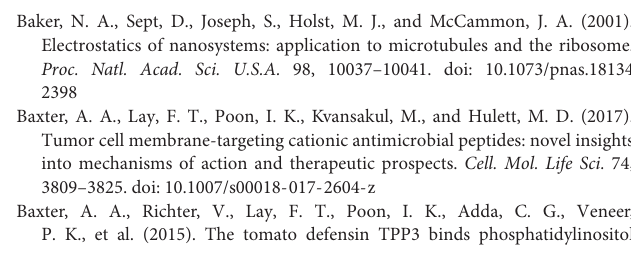
FIGURE S1 | Surface charge of ZmD32 like defensins. The structures of PaD2, NaD2, and NbD6 were modeled based on the NMR structure of ZmD32 using Swiss-Model (Guex et al., 2009) (https://swissmodel.expasy.org/). The surface charge was then mapped using the same methods as for ZmD32 and NaD1 in Figure 6 with blue indicating positive charge, red negative charge, and white neutral. The positive charge on the surface of ZmD32 is not present in PaD2 or NaD2 and is weaker in NbD6. FIGURE S2 | Fingerprint region of the (A) TOCSY and (B) NOESY spectra of ZmD32 recorded at 298 K at 600 MHz. The sequential connectivity pattern shown indicates the assignment of the peptide backbone resonances. TABLE S1 | Statistical analysis of ZmD32